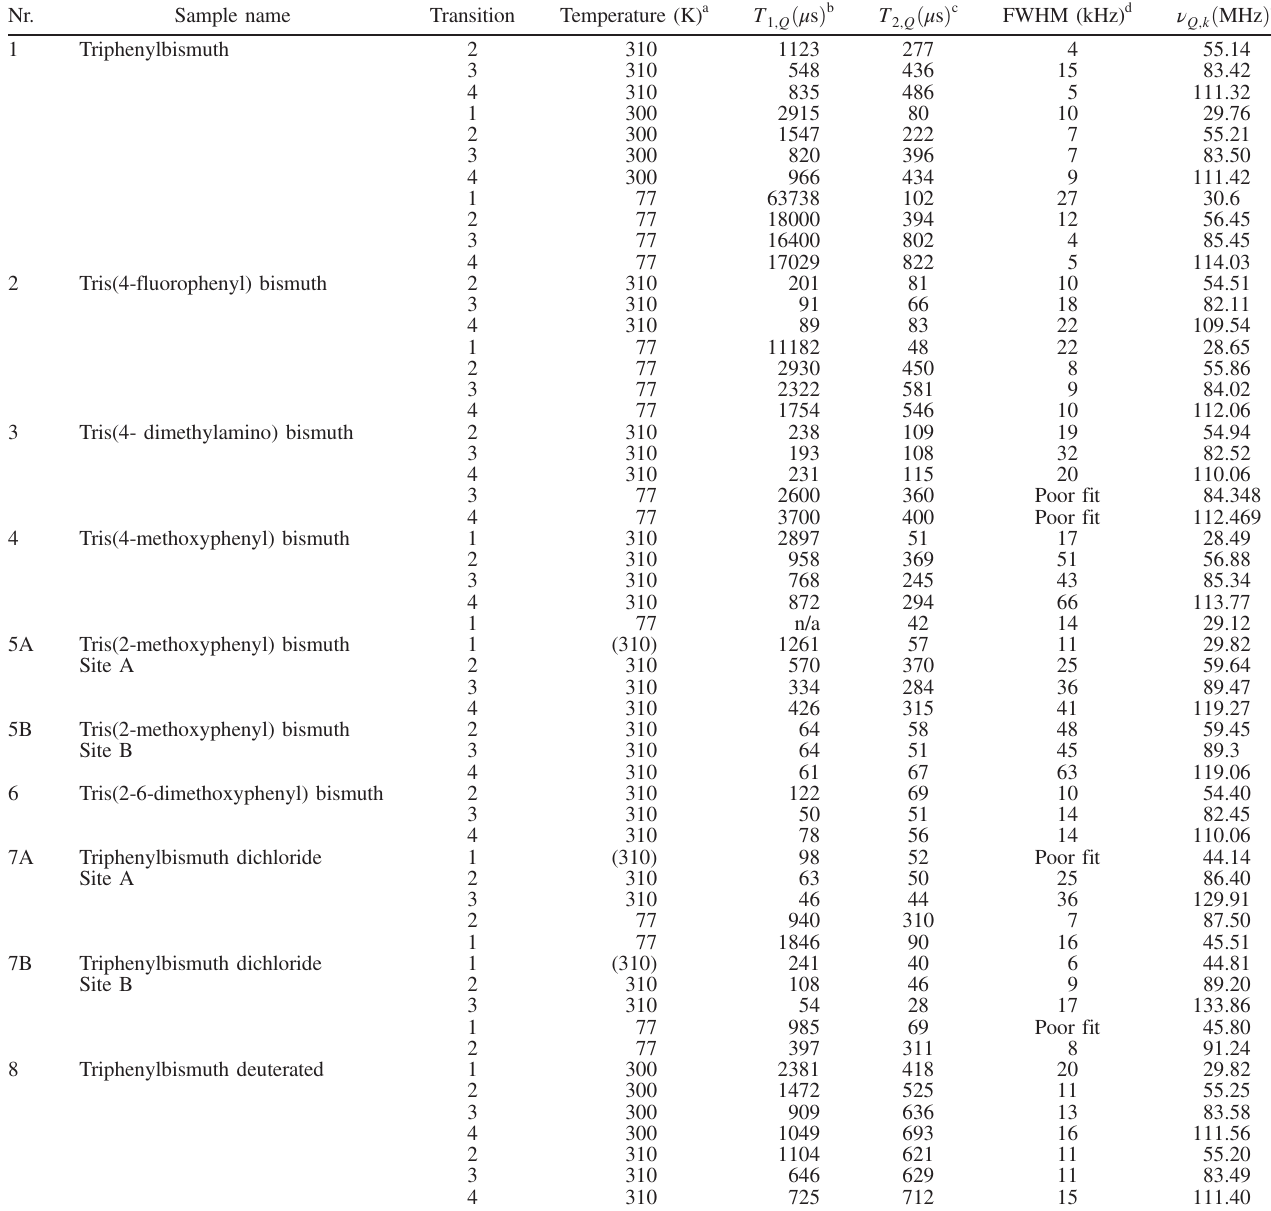
TABLE VII. Measured NQR relaxation times T 1 ;Q and T 2 ;Q , FWHM of Lorentzian peak shape, and transition frequencies ν Q;k .